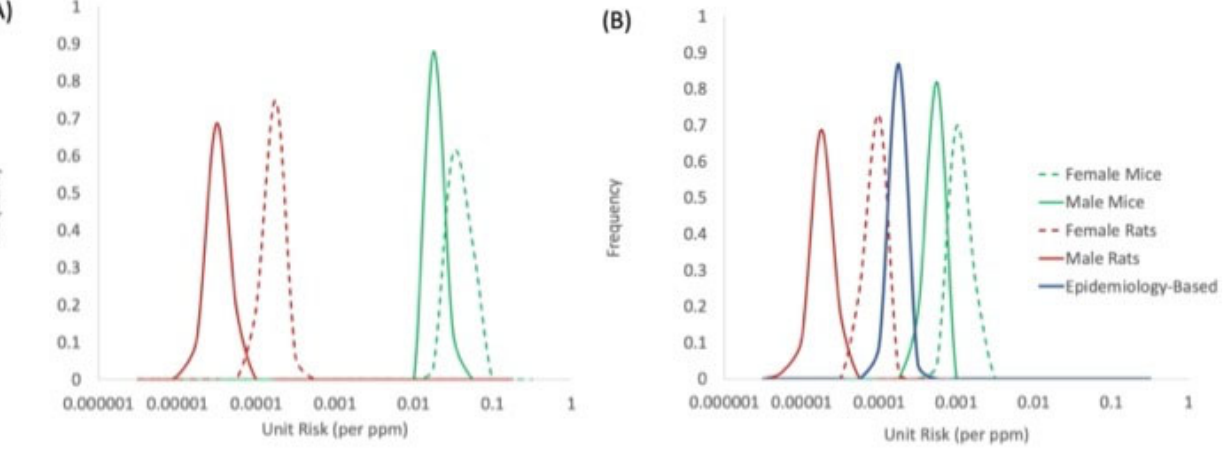
Figure 4. Concordance of unit risk distributions: ( A ) unadjusted exposure and ( B ) adjusted for species differences in internal dose and genotoxic potency of BD metabolites; unit risk values based on epidemiology data are from Valdez ‐ Flores et al. [50] .